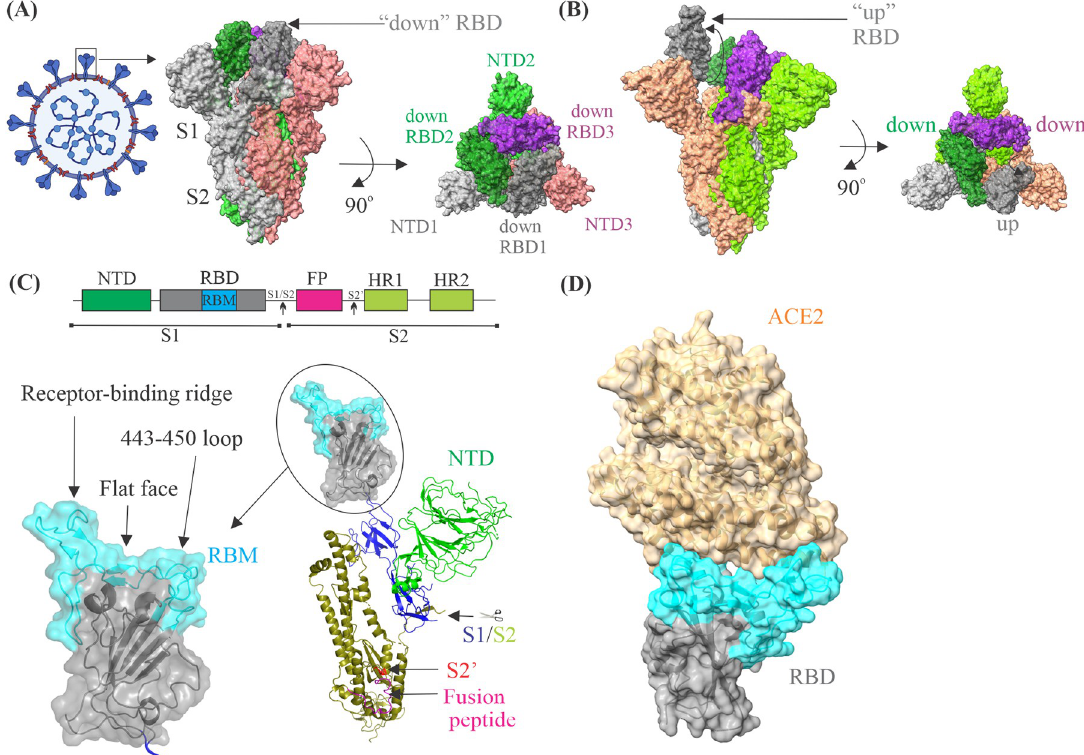
Fig 1. Structure of the SARS-CoV-2 spike protein trimer. (A) Left: side view of the trimeric spike ectodomain with 3 RBDs in the down-conformation; right: top view of the trimeric spike protein showing RBDs in gray, forest green, and orchid (PDB: 6VXX). (B) Left: side view of the trimeric spike ectodomain with 1 RBD in the up-conformation; right: top view of the trimeric spike protein showing 1 up RBD in gray (PDB: 7BNN). (C) A schematic layout of the spike protein is shown at the top. Right: structure of a monomer displaying the RBD in the open conformation. Spike protein structure shows the receptor-binding subunit S1 and the membrane-fusion subunit S2 separated by the furin-like protease site (S1/S2). Different subdomains of the spike protein are the NTD in green, RBD in gray containing RBM in cyan at their top, the fusion peptide in pink, second cleavage site S2’ in red, and HR1 and HR2 in olive (PBB: 7BNN). The scissors represent the S1/S2 boundary at amino acid position 685. Left: The open conformation RBD highlights the 3 different regions: receptor-binding ridge, flat surface, and 443–450 loop of the RBM that form the ACE2-binding region. ACE2 AU : AbbreviationlistshavebeencompiledforthoseusedinFigs 1 (cid:0) 6 : Pleaseverifythatallentriesarecorrect : , angiotensin- converting enzyme 2; FP, fusion peptide; NTD, N-terminal domain; RBD, receptor-binding domain; RBM, receptor-binding motif; SARS-CoV-2, Severe Acute Respiratory Syndrome Coronavirus